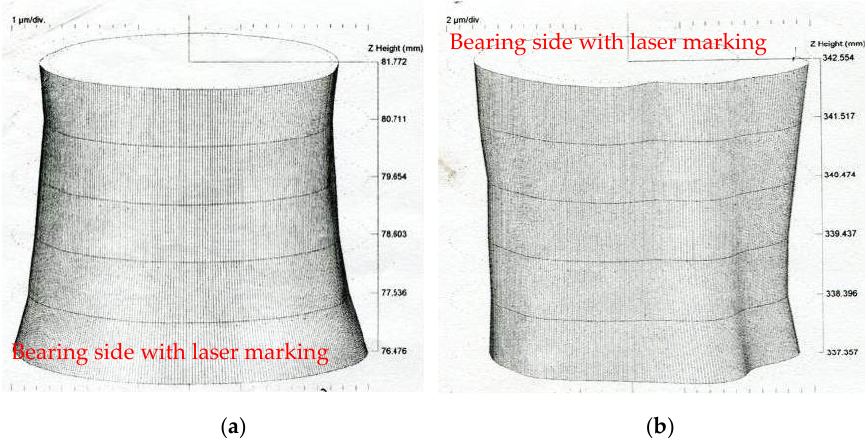
Figure 19. Cylindricity of the inner ring raceway: ( a ) before installation; ( b ) after installation. The bearing was disassembled and inspected after a 50-h test. There were obvious circumferential contact marks on the outer race raceway, a spalling area with a circumfer- ential length of about 12 mm, and an axial width of about 1.5 mm in the axial end, which corresponded to the bearing side with laser marking of the outer ring raceway, as shown in Figure 20a. There were obvious circumferential contact marks on the inner race raceway and spalling strips, whose circumferential length separately accounted for 2/3 and 1/4 of the circumference of the outer race raceway, which, in the end, corresponded to the bear- ing side with laser marking; the damage at the other end was not obvious, as shown in Figure 20b. There were obvious circumferential contact marks on the 20 rollers. Addition- ally, there were spalling strips on the end surfaces corresponding to the bearing side with laser marking of the 13 rollers, as typically shown in Figure 20c. Damages of the cage were mainly characterized by an uneven wear of the pocket and side beams, as shown in Figure 20d. ( a ) ( b ) ( c ) ( d )